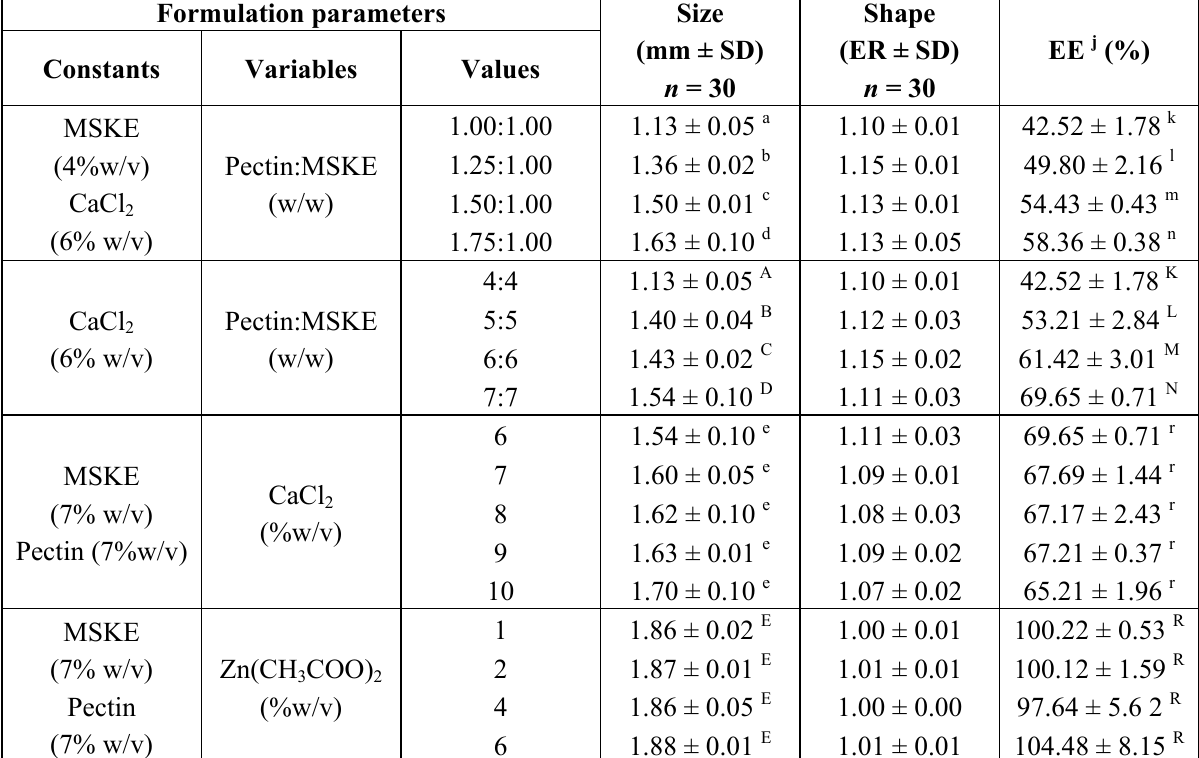
Table 1. The effects of formulation parameters on particle size, shape and EE of MSKE-loaded pectinate